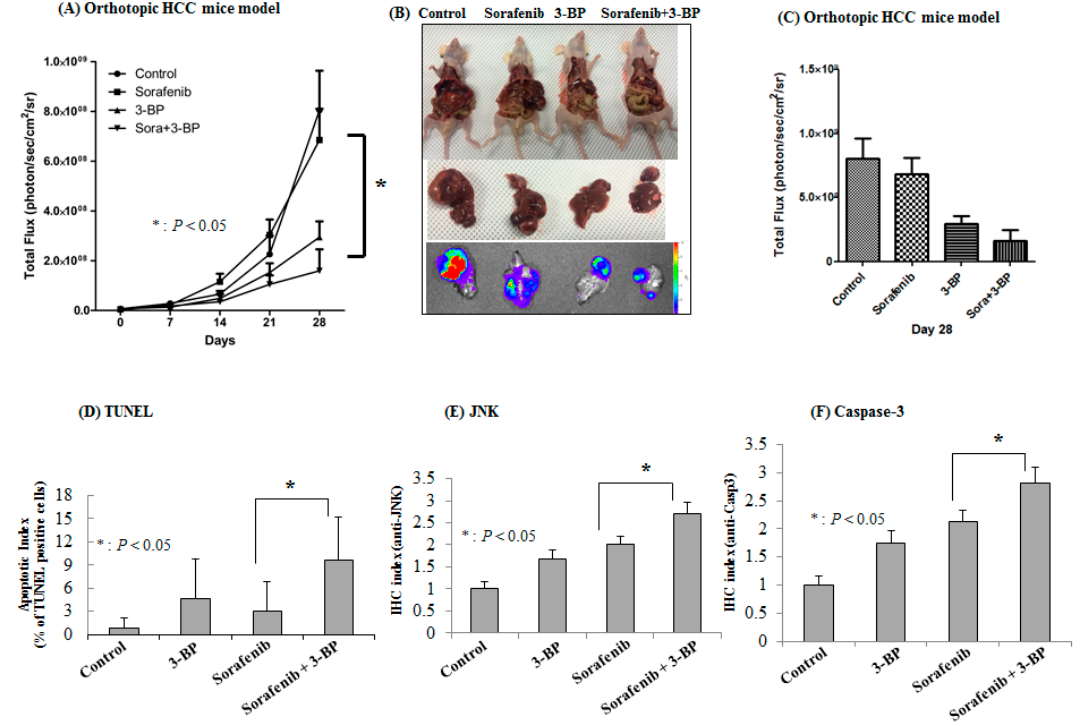
Figure 5. 3-BP improves the anti-tumor efficacy of sorafenib against orthotopic HCC tumors. ( A ) The bioluminescent image (BLI) signals of the tumor cells from the mice receiving sorafenib, 3-BP, or sorafenib + 3-BP after 28 days of treatment. ( B ) Representative ex vivo images from autopsy. ( C ) The BLI signals evaluated immediately after autopsy. ( D ) The apoptotic index, defined as TUNEL-positive cell percentages of the total number of cells. ( E ) JNK and ( F ) capsase-3 immunohistochemical staining of sections of paraffin-embedded HCC